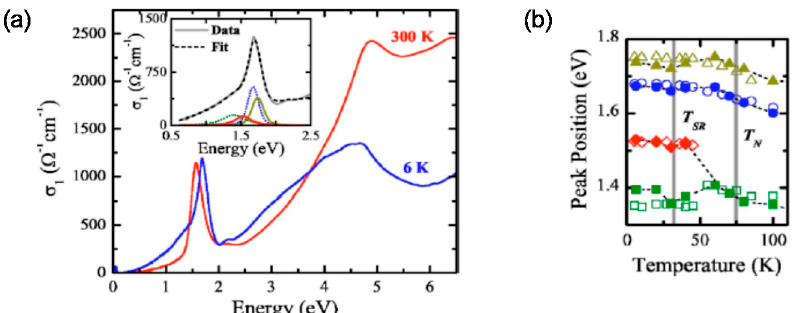
Figure 3. ( a ) Optical conductivity spectra at 6 K and 300 K in a hexagonal HoMnO 3 single crystal. The inset shows a fitted result of the spectrum at 6 K considering four components. ( b ) Peak positions of each component in the inset of ( a ) as a function of temperature. Colour of the symbol corresponds to that of the component. Open and closed symbols were estimated from different experimental data. Reprinted figures with permission from [41] Copyright (2007) by the American Physical Society.